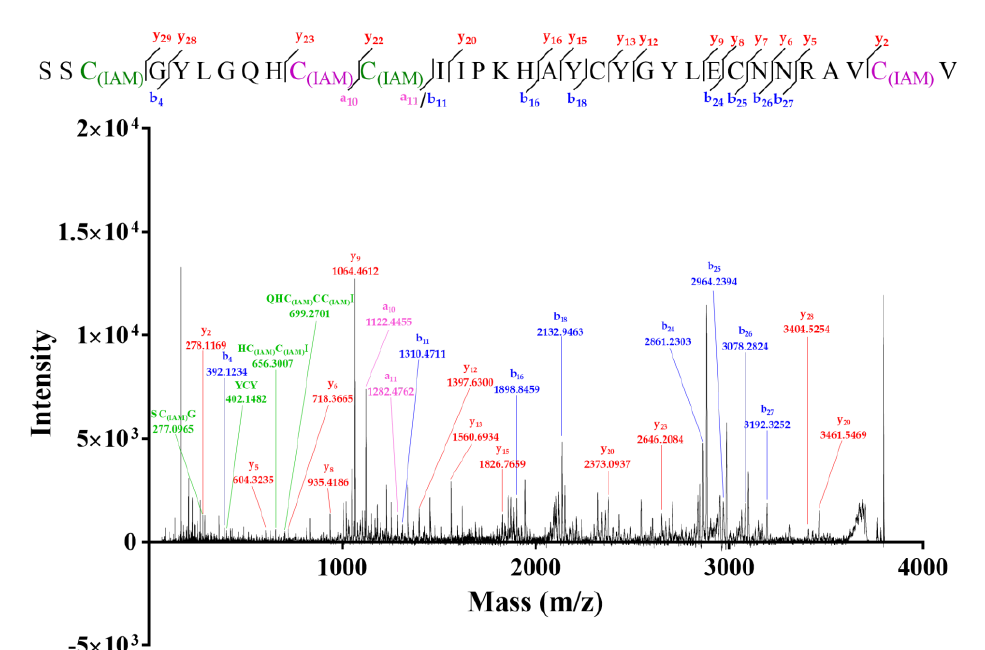
Figure 7. MALDI-TOF-MS/MS spectrum of two-cysteine-alkylated product of Lv32.1. C (IAM) repre- sented the cysteine alkylated by IAM.